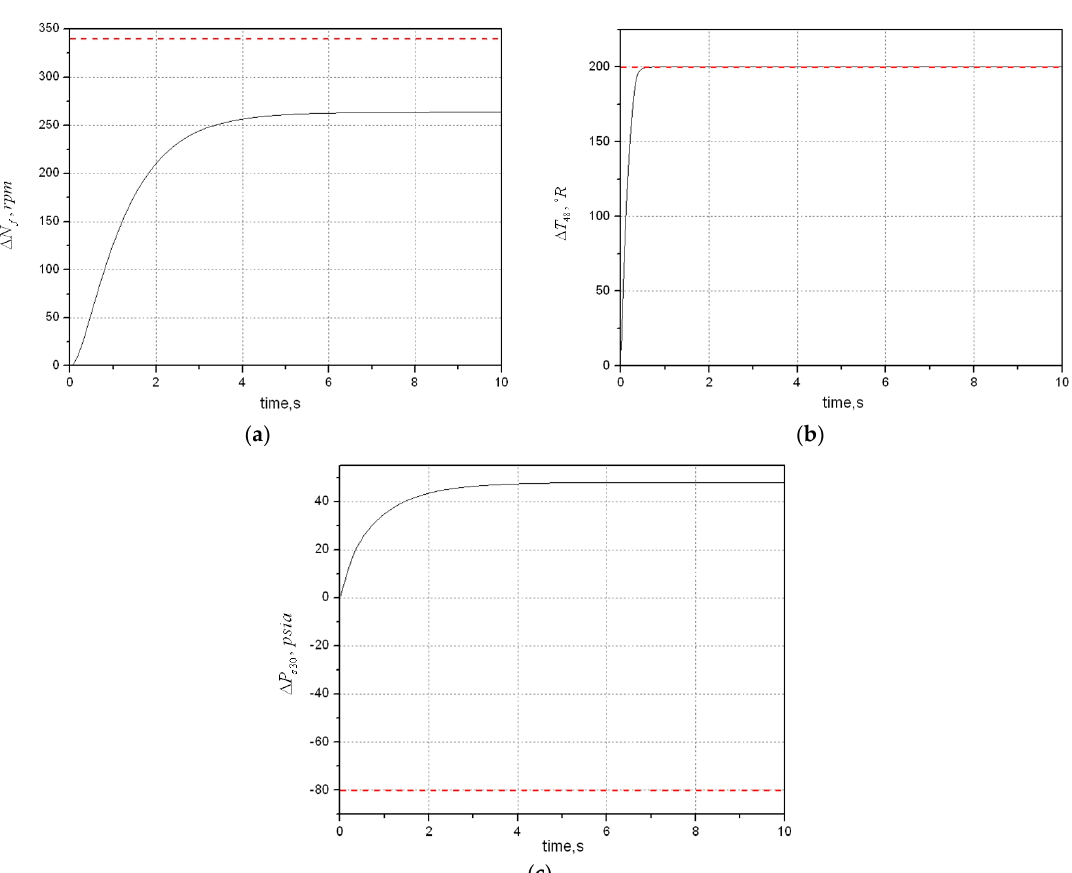
Figure 10. Control rates with OAMTC limit regulator. 4. Conclusions In this paper, an optimal angmented monotonic tracking controllers for an aircraft turbofan engine has been developed. In order to achieve monotonic tracking with zero steady-state error and guarantee transient limit protection of the auxiliary outputs, the eigenvalue and eigenvector placement method and genetic algorithms are employed to obtain an optimal solution. The key idea of this method is that the transient response of outputs is shaped in advance to eliminate overshoots, which may cause transient violations. After the OAMTC design process, the designed controllers are used to construct a min-max selector for testing the effectiveness. The simulation confirms the following two points: (1) an OAMTC controller presents strong robustness in two aspects: no steady state errors and the suppression of overshoot and undershoot in uncertainty-existing circumstances; (2) the min-max selector constructed by OAMTC controllers can avoid steady violation and transient violation effectively. Therefore, the control objectives can be well achieved by the described controller. Acknowledgments: We are grateful for the financial support of the National Nature Science Foundation of China (No. 51276087). Author Contributions: Jiakun Qin and Jinquan Huang contributed in developing the ideas of this research. Jiakun Qin and Muxuan Pan performed this research. All of the authors were involved in preparing this manuscript. Conflicts of Interest: The authors declare no conflict of interest. References